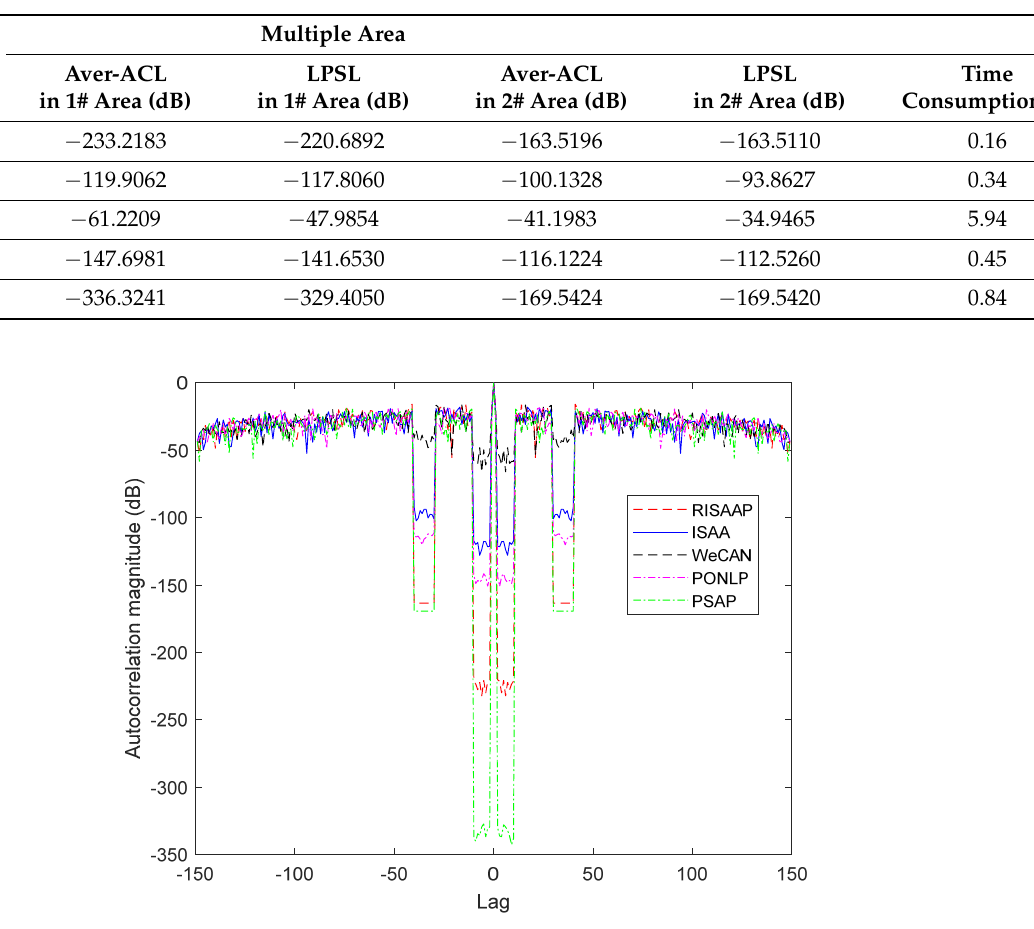
Figure 4. ACL comparison for suppressing sidelobes for multiple areas.